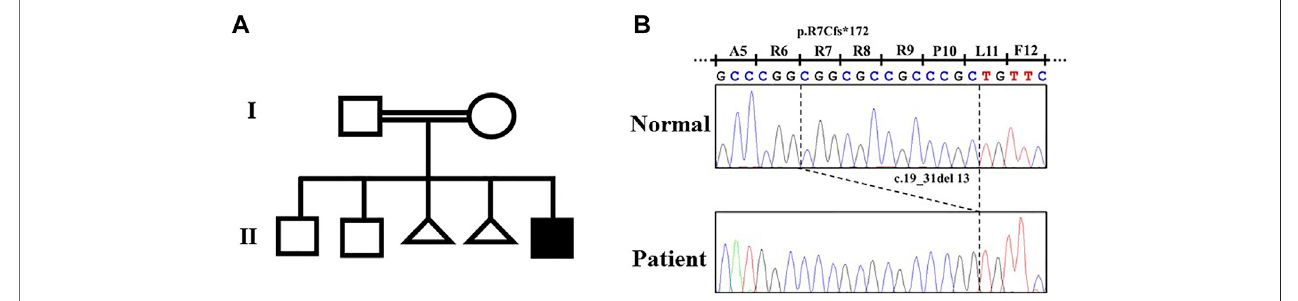
FIGURE 2 | Pedigree of the family with dysosteosclerosis and the TNFRSF11A variant. (A) Pedigree. (B) Electropherograms of the Sanger sequence analysis.